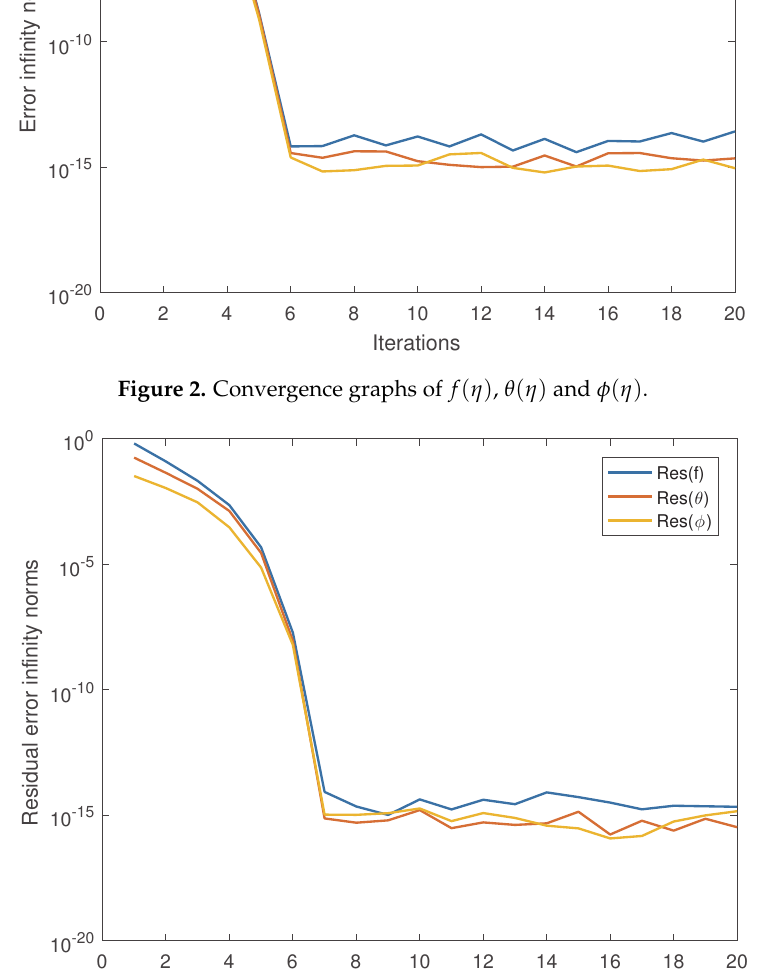
Figure 3. Accuracy graphs of f ( η ) , θ ( η ) and φ ( η )